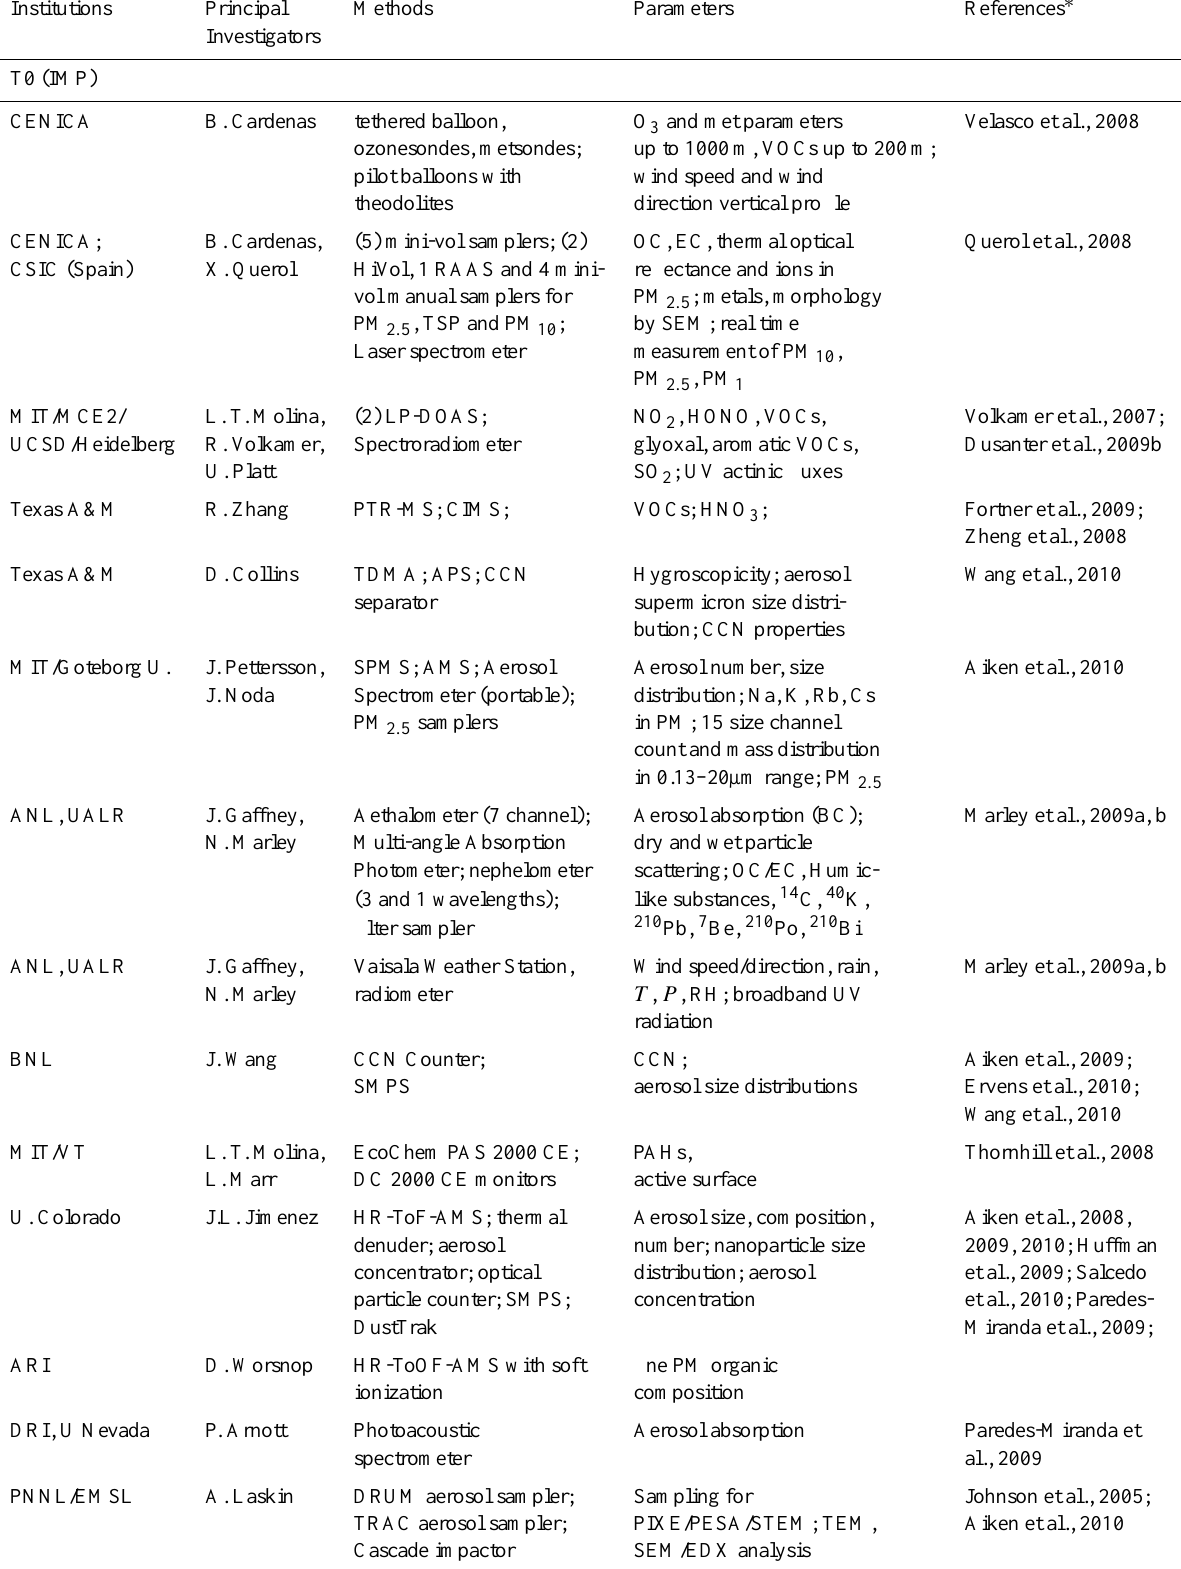
Table 1. List of participating institutions and instruments deployed at the urban